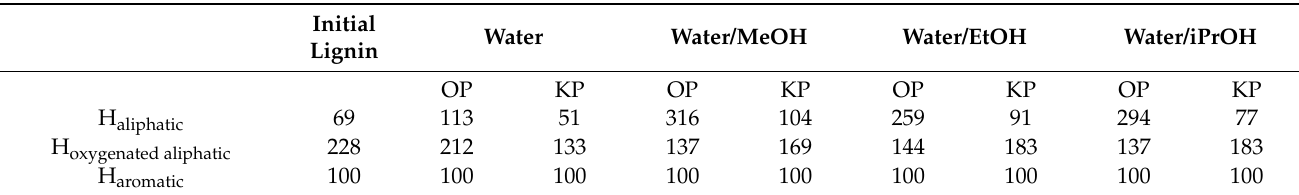
Table 5. Semi-quantitative determination of the aliphatic protons occurrence in NMR spectra calculated based on 100 aromatic protons.